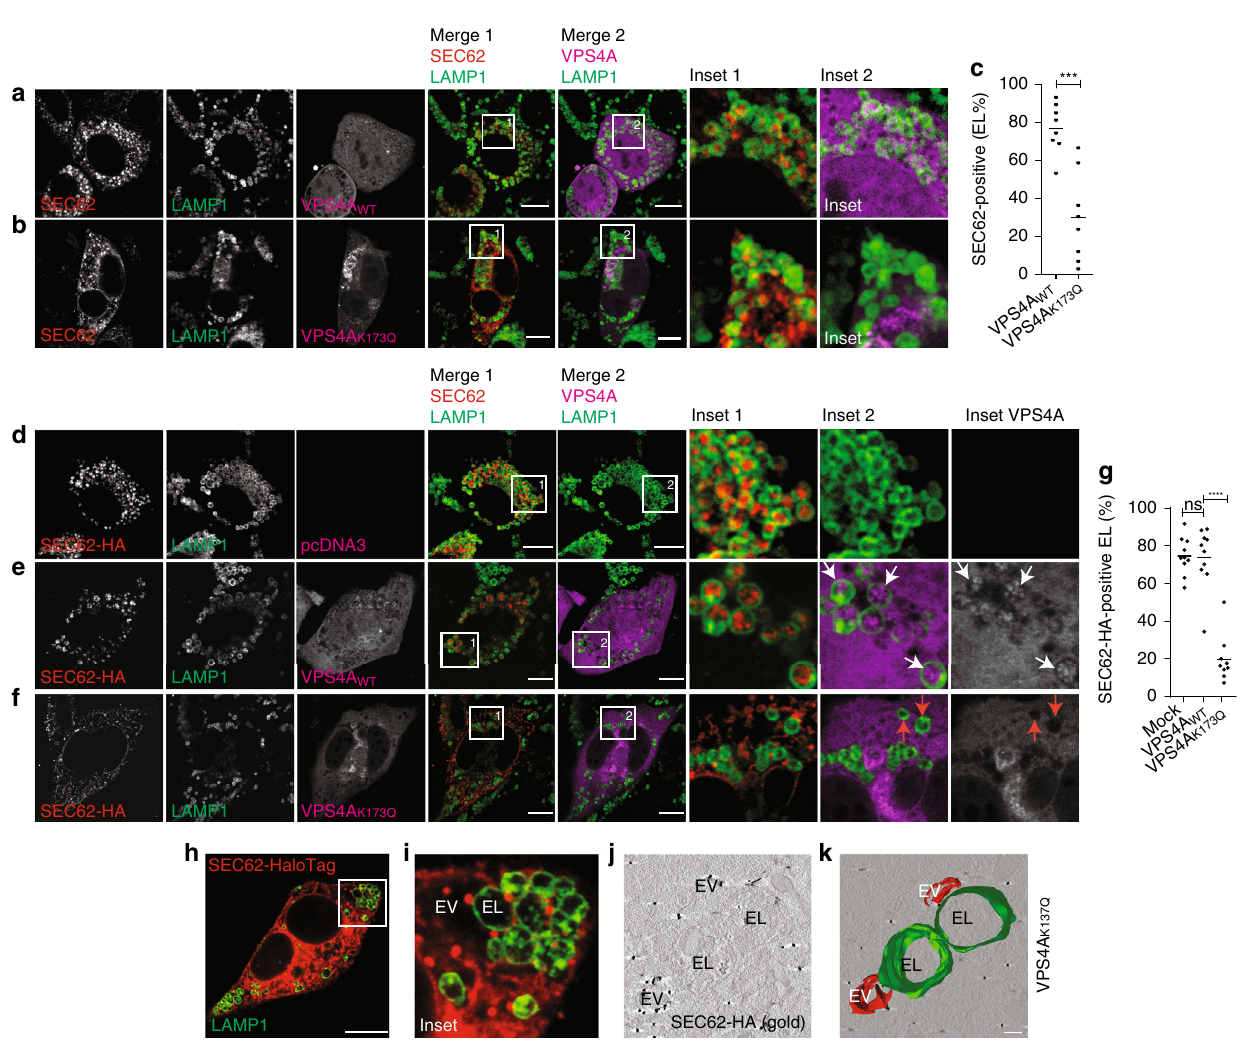
Fig. 6 A role of VPS4A in recov-ER-phagy. a Same as Fig. 1b in MEF transfected with a plasmid for expression of GFP-VPS4A (VPS4A WT ). b Same as a in cells transfected with a plasmid for expression of GFP-VPS4A K137Q (VPS4A K137Q ). c Quanti fi cation of EV delivery within EL in a , b ( n = 8, 8 cells, respectively). Unpaired, two-tailed t test, *** P = 0.0002. Data are representative of three independent experiments with similar results. d Delivery of SEC62-HA within LAMP1-positive EL in MEF transfected with an empty plasmid exposed to BafA1 for 12 h. e Same as d in cells transfected with a plasmid for expression of GFP-VPS4A WT . f Same as d in cells transfected with a plasmid for expression of GFP-VPS4A K137Q . g Quanti fi cation of EV delivery within EL in d – f ( n = 10, 10, 9 cells, respectively); ANOVA and Dunnett ’ s multiple comparisons test, n.s. P > 0.05, **** P < 0.0001. Data are representative of at Fig. 3. i inset of h . Scale bars: 10 μ m. j Single slice of an electron tomogram. k 3D visualization by electron tomography of SEC62-positive EV adjacent to EL. For j , k , IEM images are representative of two independent experiments with similar results. Scale bar: 250 nm. See Supplementary Movie